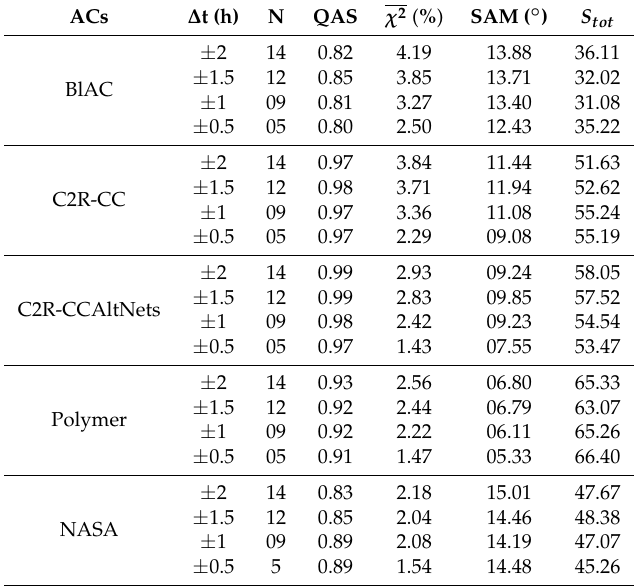
Table 3. Values of QAS, χ 2 , SAM, and S tot associated with different time windows and the AC common match-ups. N is the number of match-ups, and ∆ t is the time